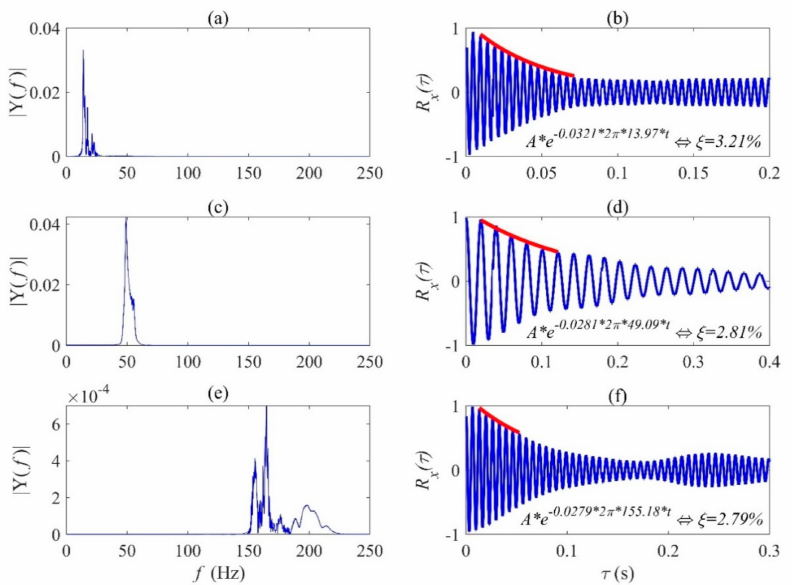
Figure 16. Fourier spectra and ACF of IMFs extracted from a 4 sensor of test #B conducted on the wind turbine blade; ( a , b ) IMF1; ( c , d ) IMF2; ( e , f )